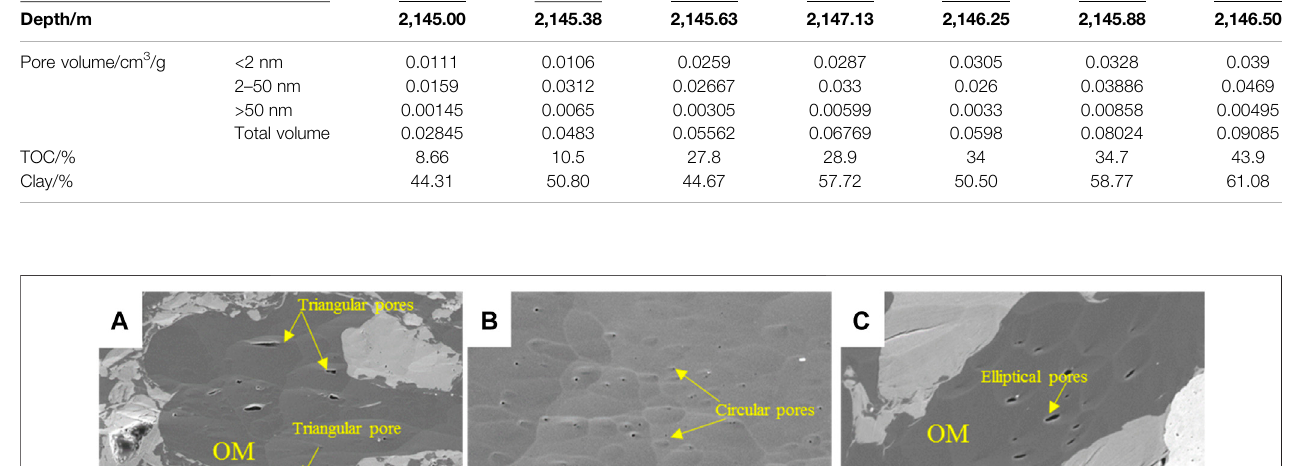
Frontiers in Earth Science |